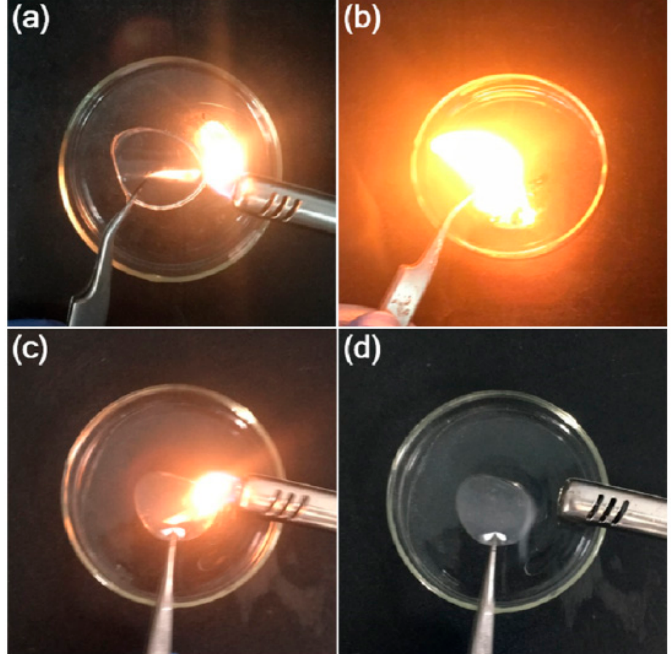
Figure 10. Flame ignition tests for ( a ) GPE-LE and ( c ) GPE-SN-IM. After contacting the flame, ( b ) GPE-LE quickly burns, but ( d ) GPE-SNIM does not burn [42]. Reprinted with permission by the American Chemical Society from Robust Succinonitrile-Based Gel Polymer Electrolyte for Lithium-Ion Batteries Withstanding Mechanical Folding and High Temperature; P. Lv, Y. Li, Y. Wu, G. Liu, H. Liu, S. Li, C. Tang, J. Mei, and Y. Li; © 2018.